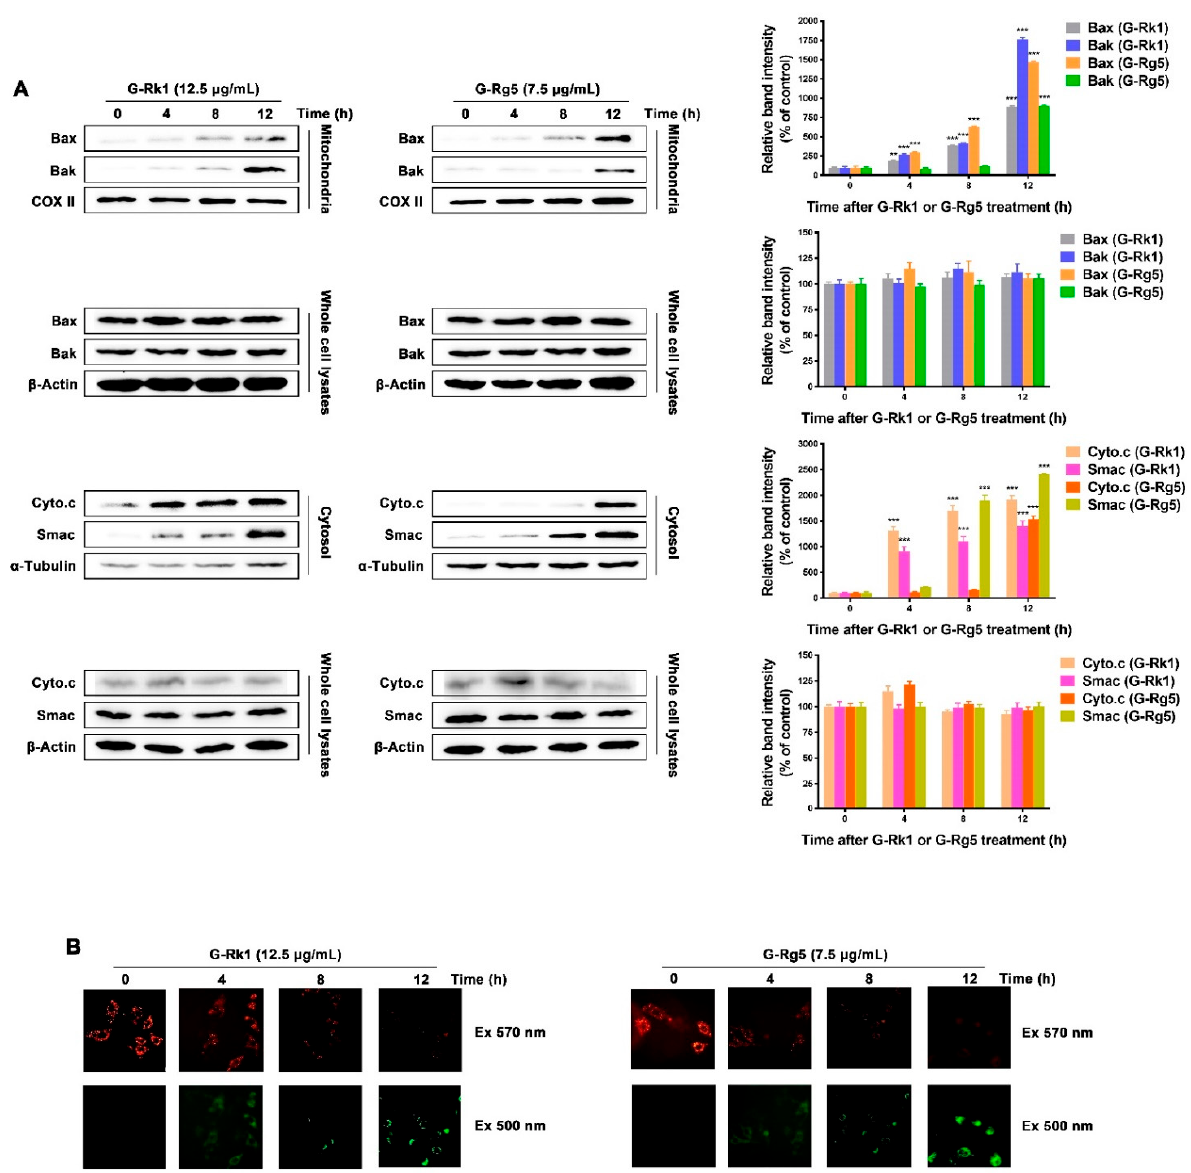
Figure 3. G-Rk1 or G-Rg5 induced apoptosis of MHCC-97H cells is mediated through Bax/Bak translocation and release of cytochrome c /Smac. ( A ) G-Rk1 or G-Rg5 induced Bax/Bak translocation from cytoplasm to mitochondrial outer-membrane and release of cytochrome c /Smac were analyzed by immunoblotting for the indicated times. The right panel is quantitative analysis of Western blot. Data are shown as the mean ± SD of experiments performed in triplicate. A Student’s t -test was used for quantitative analysis with *** presenting p < 0.001 and ** presenting p < 0.01. ( B ) MHCC-97H cells were treated with 12.5 µ g/mL G-Rk1 or 7.5 µ g/mL G-Rg5 for the indicated times and stained with MitoCapture cation dye. The same fields of cells were visualized with excitation wavelengths of 570 nm and 500 nm,